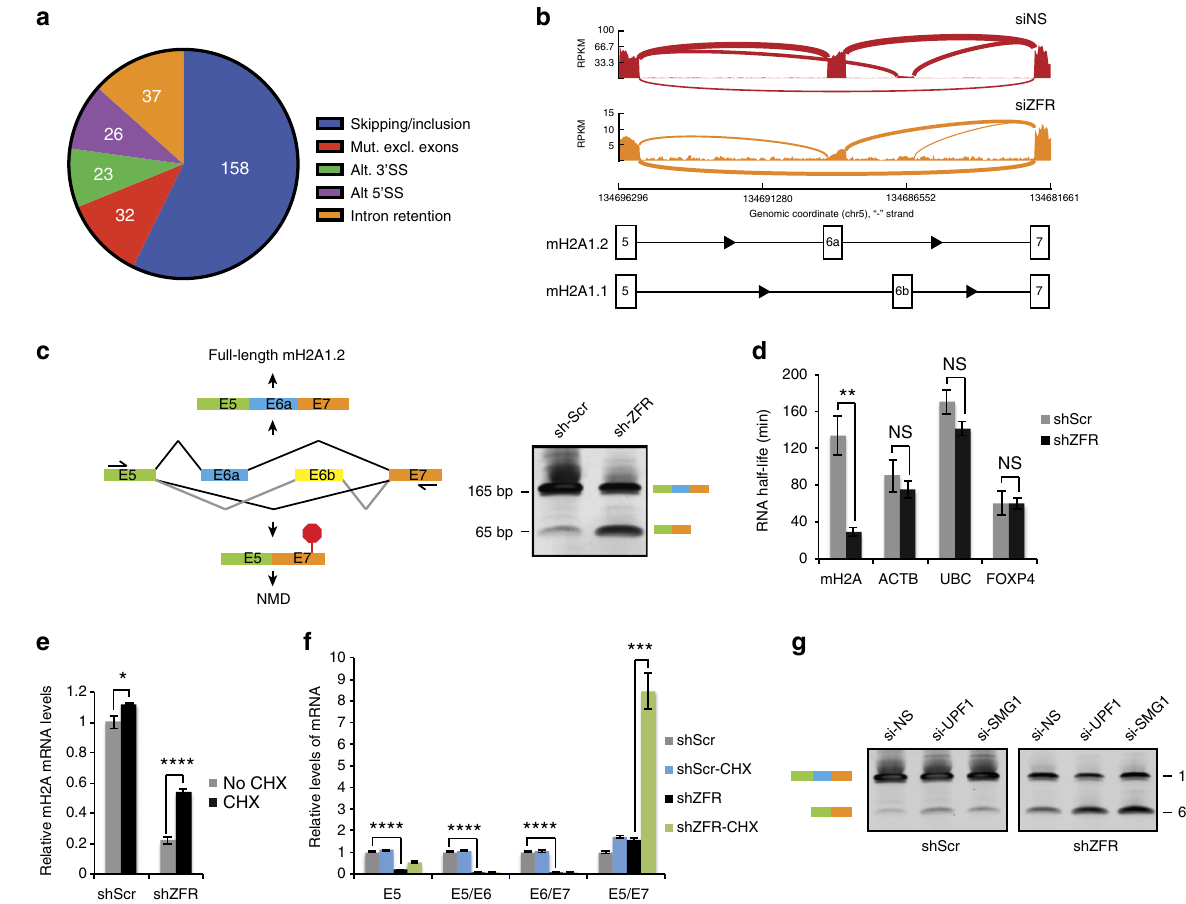
Fig. 2 ZFR regulates alternative splicing and decay of mH2A1 mRNAs. a MISO analysis of alternative splicing in ZFR knockdown cells. Numbers of alternative splicing events of the indicated types identi fi ed with bayes factor > 20 and change in isoform usage of | Δ Ψ | > 0.12 are shown. b Sashimi plot illustrating skipping of mH2A1 exons 6a (mH2A1.2 isoform) and 6b (mH2A1.1 isoform) in ZFR knockdown cells. RNA-seq read densities from representative replicates are shown; note that ZFR RNAi plot is re-scaled to allow visualization of the low levels of mH2A1 mRNA. c Left: schematic depicting incorporation of a PTC upon skipping of both E6a and E6b of mH2A1 pre-mRNA, generating a potential NMD substrate. Right: RT-PCR with primers spanning differentially included E6a of mH2A1 RNA. HEK-293TO cells were stably transduced with the indicated shRNAs; schematic depicts long (top band) and short (bottom band) isoforms. d Half-lives of indicated mRNAs were determined by metabolic labeling of newly synthesized RNA ( n = 3) in cells stably transduced with shZFR or shScr. e qRT-PCR analysis of mH2A1 with and without treatment with cycloheximide (CHX; n = 3). f qRT-PCR as in e , performed with primers speci fi c to the indicated mH2A1 exon – exon junctions. g RT-PCR with primers spanning E5 – E7 of mH2A1 RNA from HEK-293TO cells transfected with siRNAs speci fi c to UPF1 (si-UPF1), SMG1 (si-SMG1), or non-targeting control siRNA (si-NS); schematic on left depicts long and short isoforms of mH2A. Approximate MW based on size markers is shown. Graphs indicate mean ± SD; * P < 0.05, ** P < 0.01, *** P < 0.001, **** P < 0.0001 (two- tailed Student ’ s t